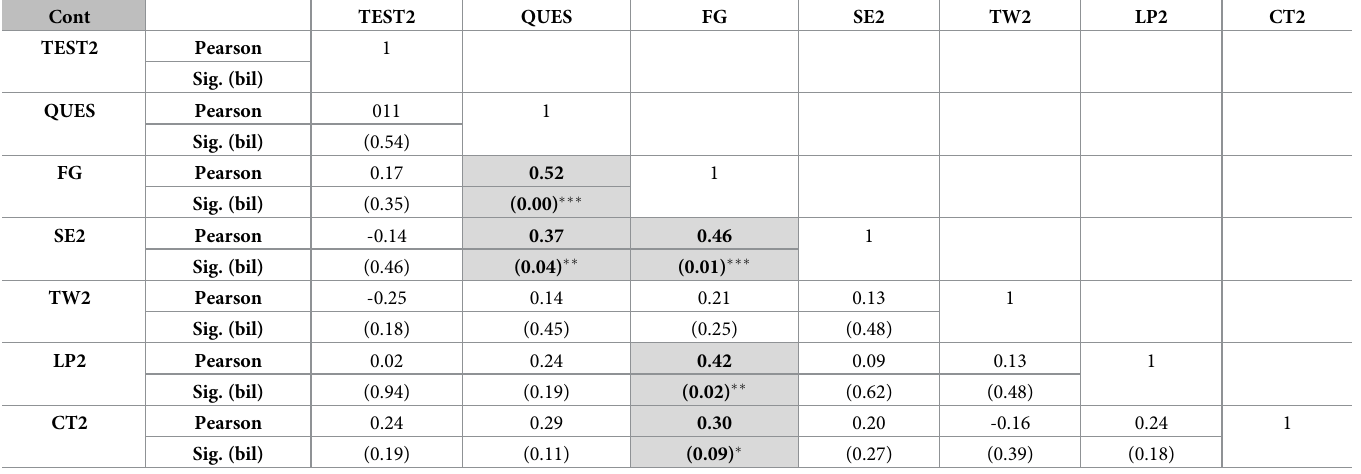
Table 10. Pearson correlations: Control group after the experiment.